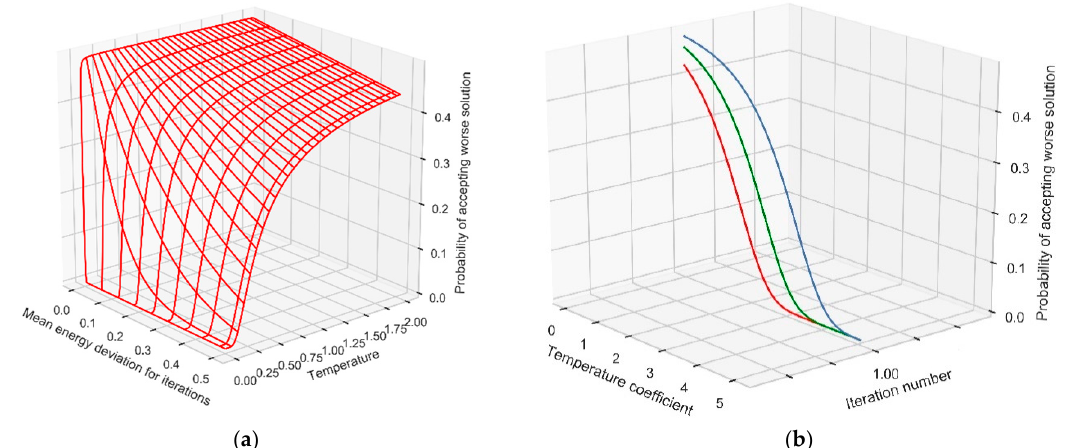
Figure 2. Graphical representations of the probability of accepting a worse solution: ( a ) surface p ws ( ∆ E k , T 0 , n = 30 ) , according to Equation (17); ( b ) set of p ws ( C , n = 30 ) for the following series of objective function deviation ∆ E k values: blue line, ∆ E k = 0.10; green line, ∆ E k = 0.25; red line, ∆ E k =